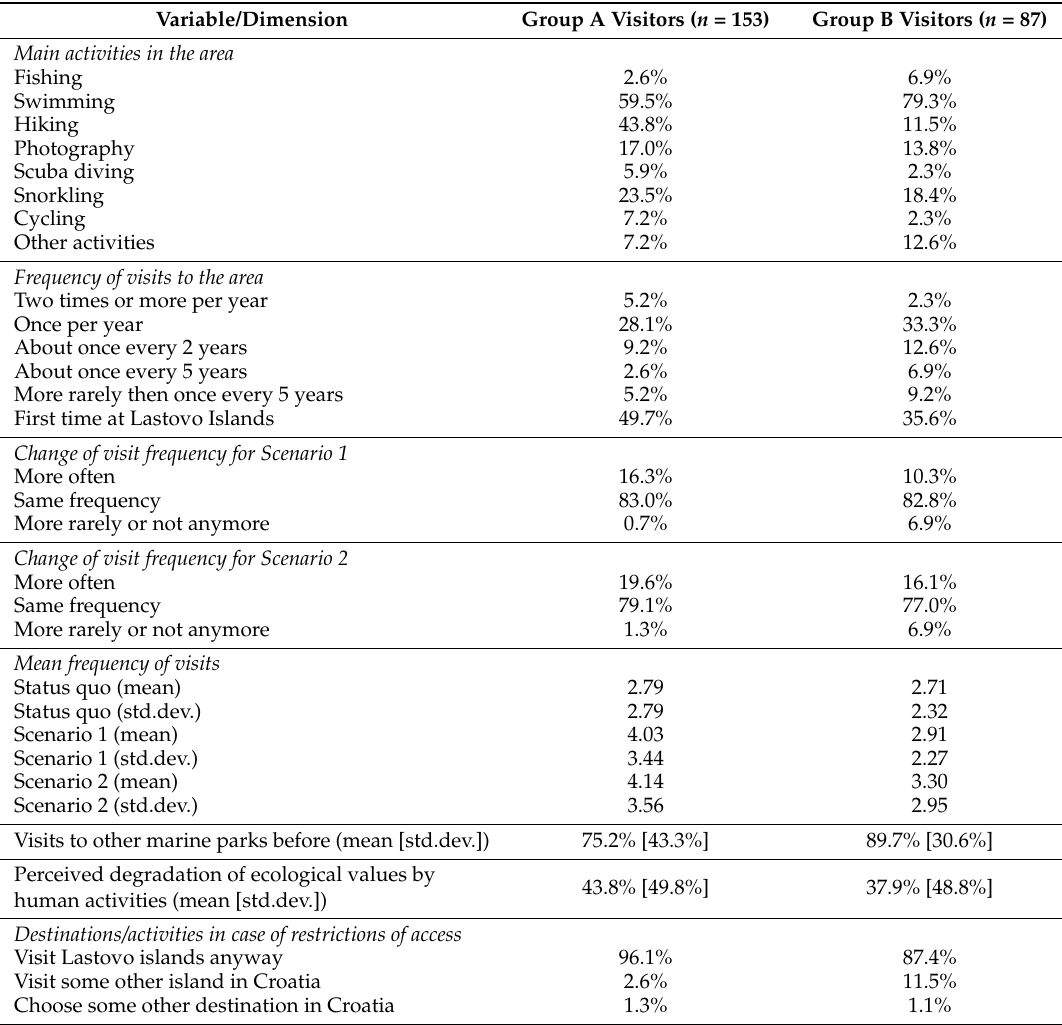
Table 3. Descriptive results: visiting Lastovo